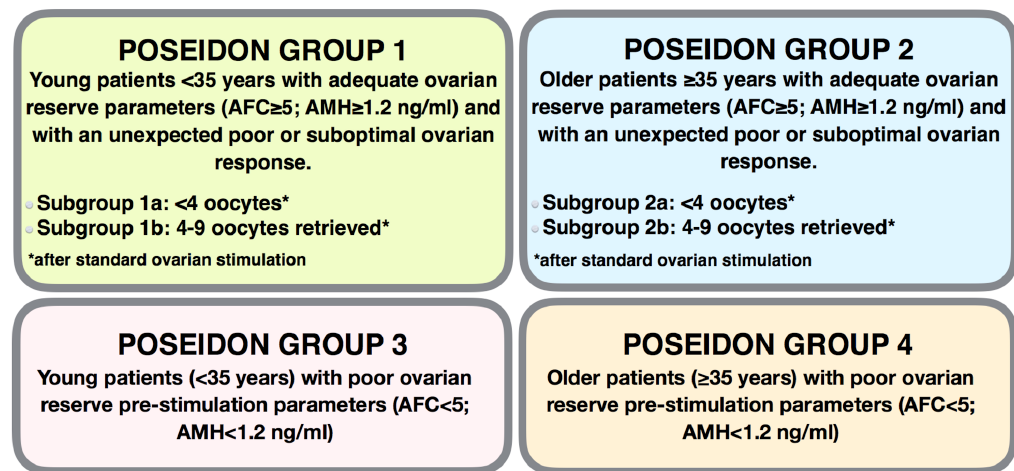
Figure 1. Four groups of ‘low prognosis patients’ in assisted reproductive technology according to the POSEIDON’s stratification based on oocyte quantity and quality. AFC: antral follicle count; AMH: anti-Müllerian hormone. Adapted with permission from Elsevier; Poseidon Group (Patient-Oriented Strategies Encompassing IndividualizeD Oocyte Number)., Alviggi C, Andersen CY, Buehler K, Conforti A, De Placido G, Esteves SC, Fischer R, Galliano D, Polyzos NP, Sunkara SK, Ubaldi FM, Humaidan P. A new more detailed stratification of low responders to ovarian stimulation: from a poor ovarian response to a low prognosis concept. Fertil Steril. 2016